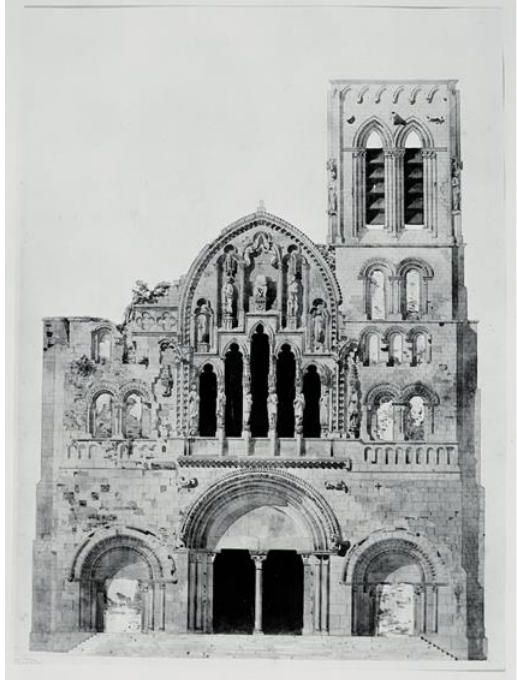
Figure 11. Abbey of Santa Magdalena de Vézelay. Engraving of the main façade in the state prior to the restoration works directed by Viollet Le Duc. 1840. Source: The Facade of La Madeleine de Vézelay. Technique: pen and ink and watercolour on paper) Paris, Caisse Nationale des Monuments Historiques.